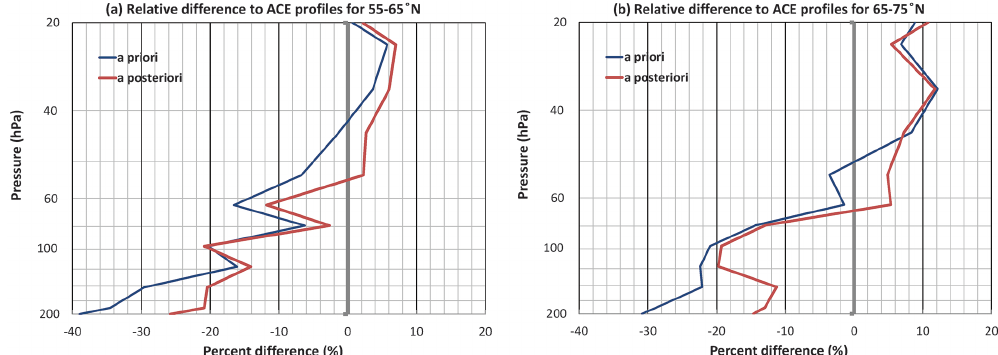
Figure 5. Relative difference between the a priori and a posteriori modeled O 3 and ACE-FTS O 3 data. Shown are the mean differences for latitudes between 55–65 ◦ N (a) and between 65–75 ◦ N (b) .